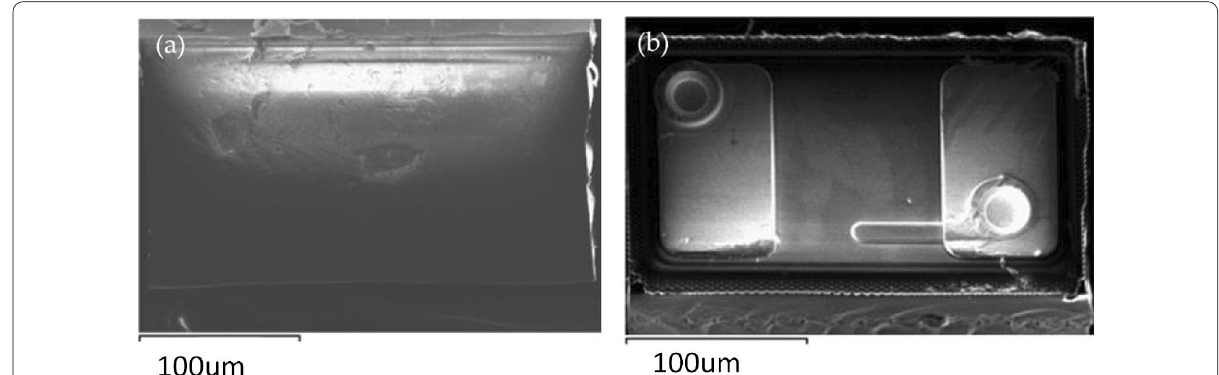
Fig. 6 Images of micro‑LEDs obtained using a scanning electron microscope. a top and b bottom views